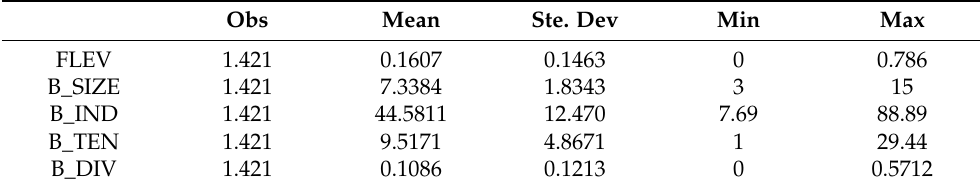
Table 2. Summary